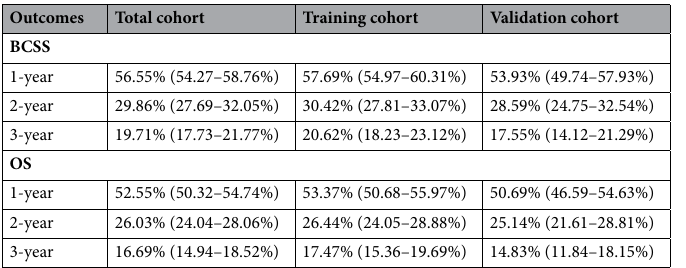
Table 2. The estimated 1-, 2-, and 3-year BCSS and OS in total, training, and validation cohort. BCSS breast cancer-specific survival, OS overall survival.